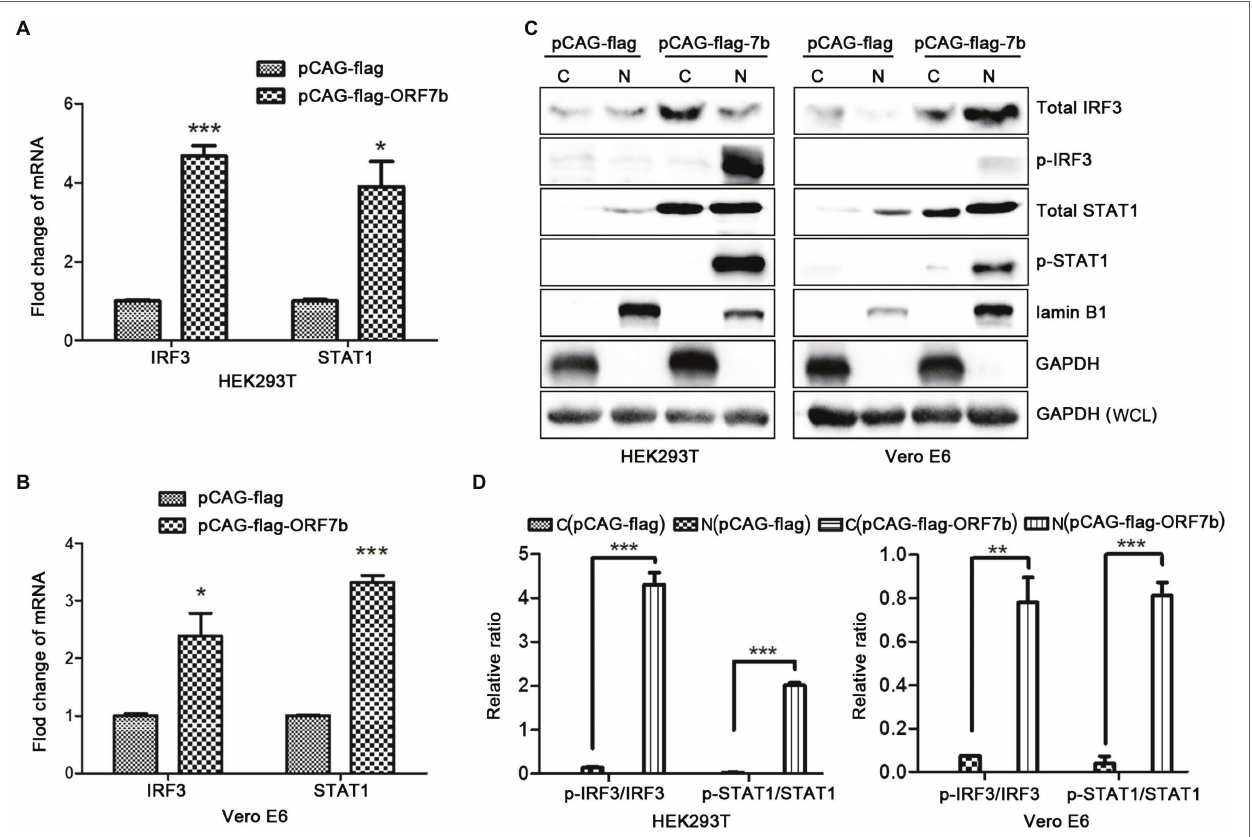
FIGURE 3 | ORF7b activates the type-I interferon (IFN) signaling pathway. (A) mRNA expression of interferon regulatory transcription factor (IRF)-3 and signal transducer and activator of transcription (STAT)-1 in HEK 293 T cells were determined by QRT-PCR at 18 h after transfection with pCAG-flag and pCAG- flag-ORF7b. (B) mRNA expression of IRF3 and STAT1 in Vero E6 cells was determined by QRT-PCR at 18 h after transfection with pCAG-flag and pCAG-flag- ORF7b. (C) Protein expression of total STAT1, total IRF3, p-STAT1, and p-IRF3 in the cytoplasm (C) or nucleus (N) of Vero E6 cells and HEK293T cells was measured by Western blotting after transfection with pCAG-flag-ORF7b for 18 h. (D) Calculation of the expression of total STAT1,total IRF3, p-STAT1, and p-IRF3 in the cytoplasm or nucleus of Vero E6 cells and HEK293T cells. The quantification was finished by ImageJ for three times. Data are shown as mean ± SD, n = 3. * p < 0.05; ** p < 0.01; *** p < 0.001, compared with the control group (Student’s t -test was used for analysis of A,B and one-way ANOVA Tukey’s post-hoc test was used for D